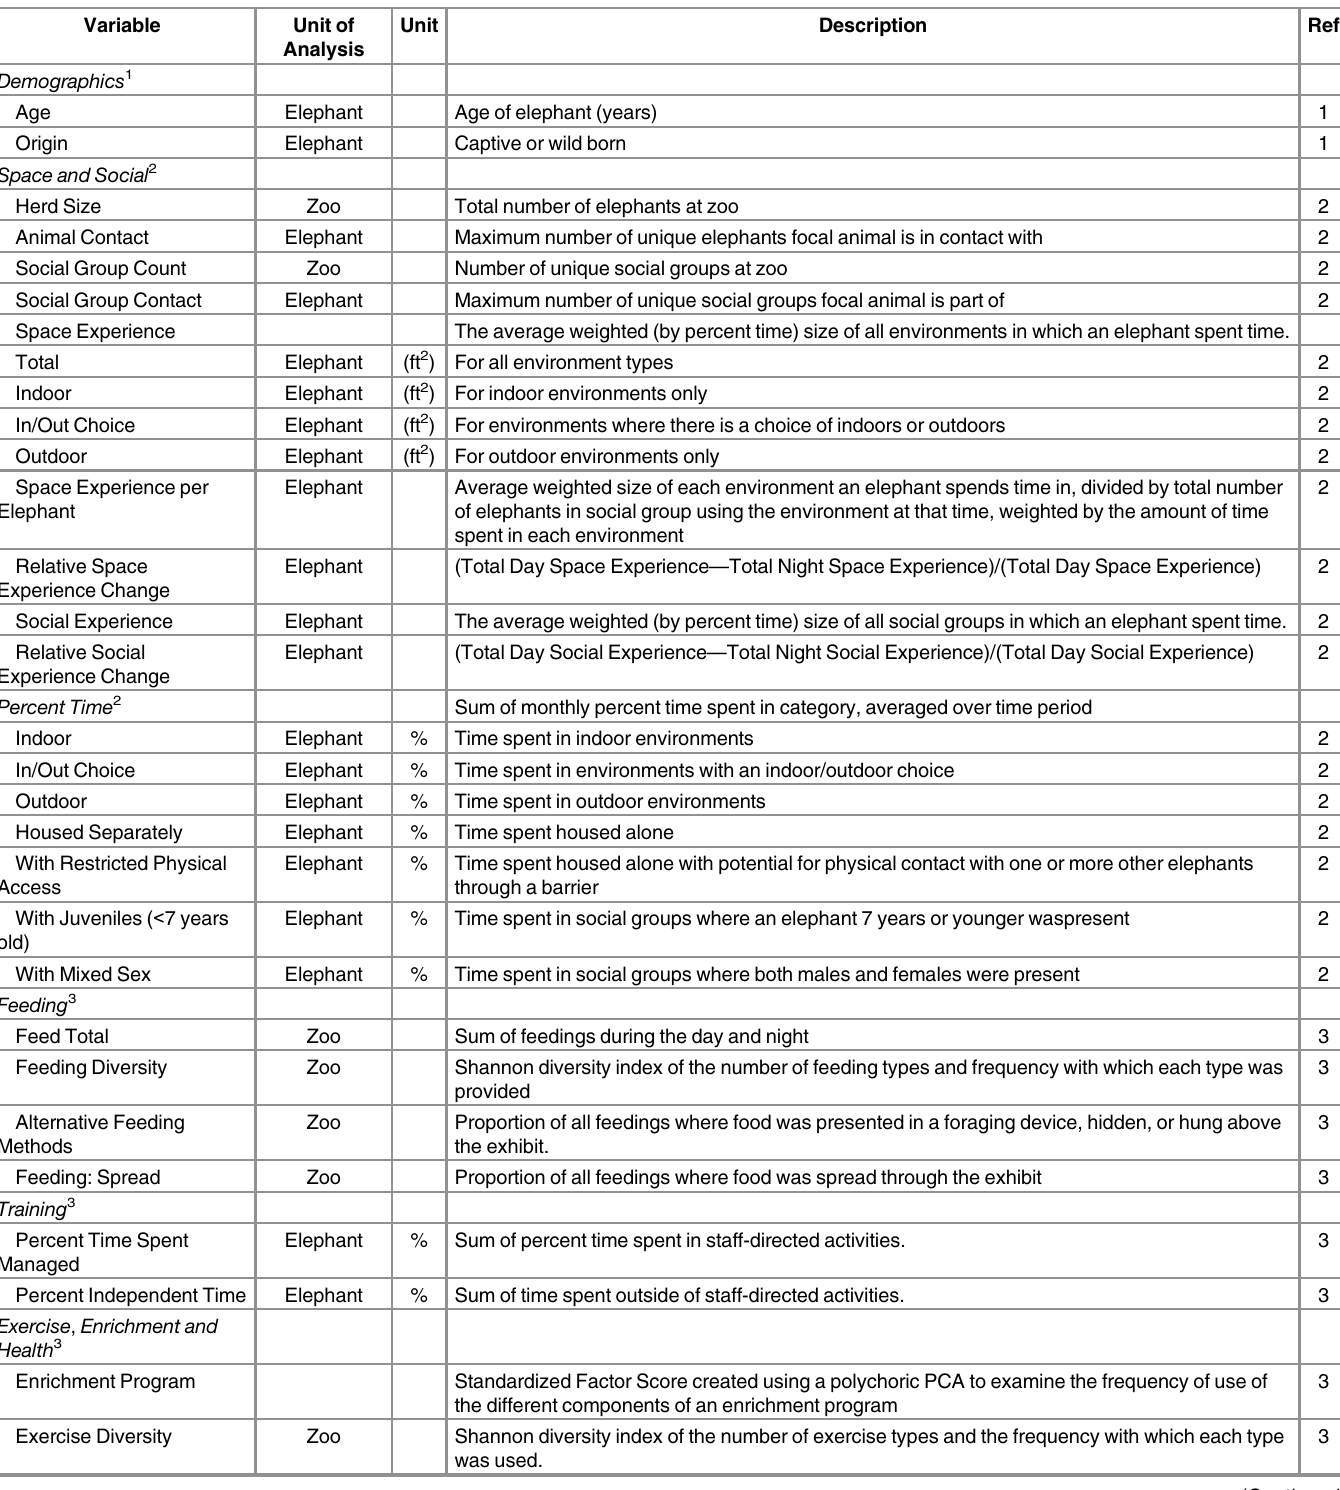
Table 1. Description of variables used in analysis of cyclicity for Asian and African elephants and hyperprolactinemia for African